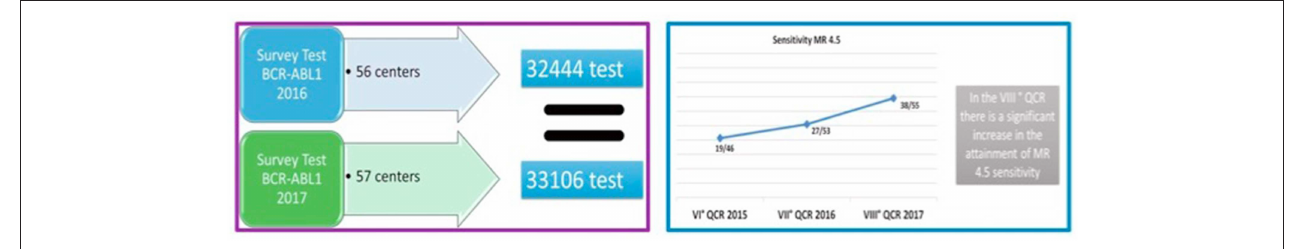
FIGURE 3 | Increasing number of laboratories of the Italian LabNet network being able to attain a sensitivity level of MR 4.5 ( BCR-ABL1/ABL1 ratio =